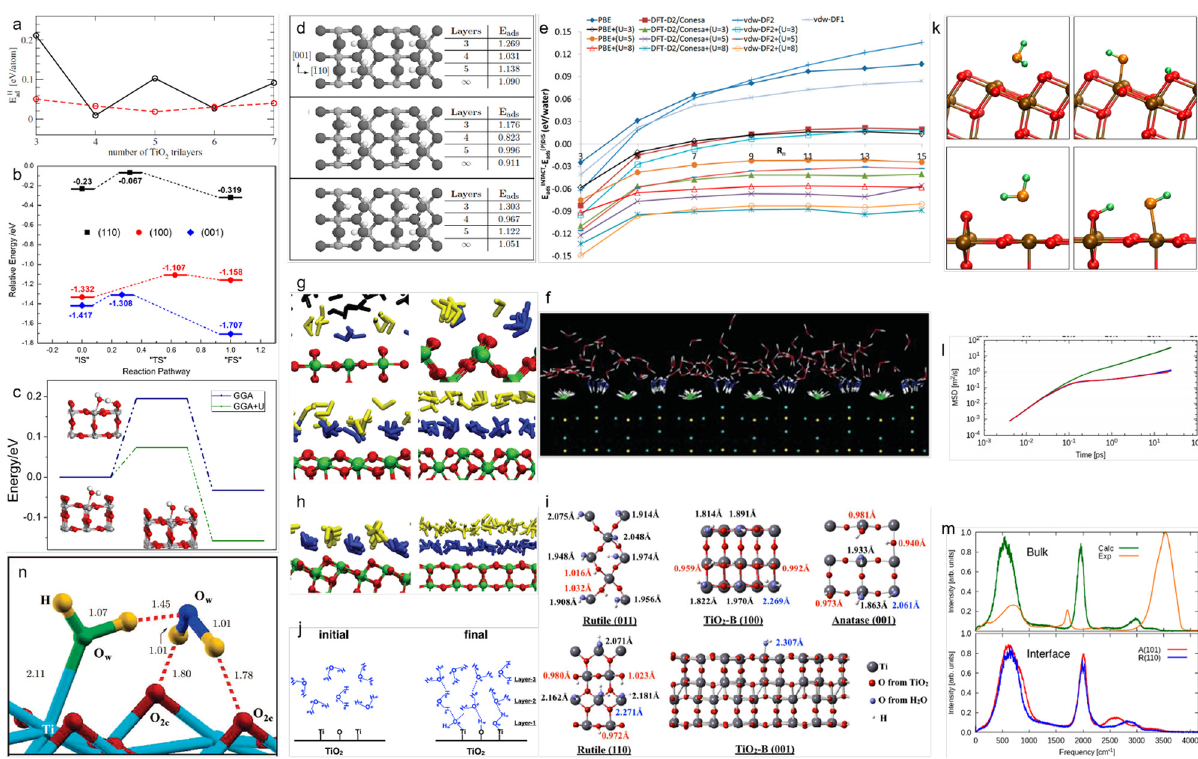
Figure 4: ( a ) Convergence of the hydrogen adsorption energy E adH with slab thickness at full monolayer coverage, reprinted with